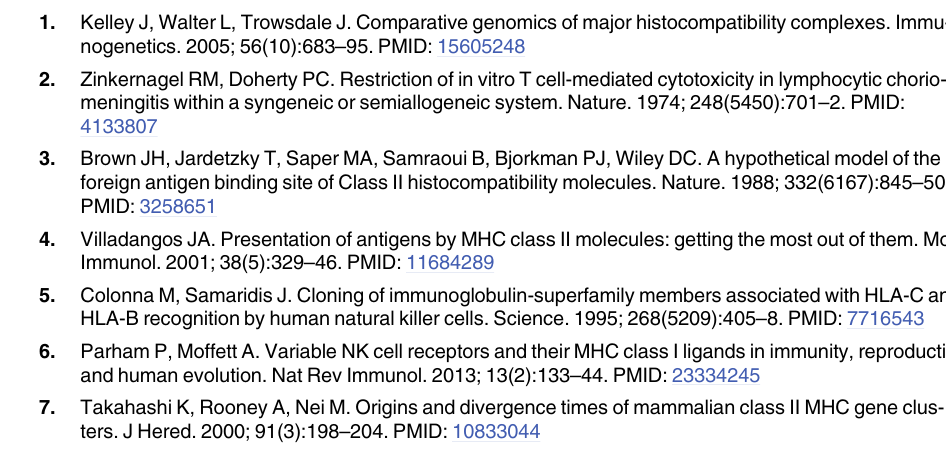
S2 Table. Characteristics of the chimpanzee fecal samples used for the detection SIVcpz vRNA. Listed are samples of chimpanzee feces that were all shown to contain SIVcpz-specific antibodies by western blotting. These samples are grouped according to the 30 chimpanzees from which they were collected. For each chimpanzee, the identity numbers and the Patr-B types are given. For each fecal sample, the identity number, the date of collection, and the com- munity territory (northern [N], central [C], or southern [S]) in which the collection was made, are given. These data are followed by the results of testing for the presence (+) or absence (-) of vRNA detected by PCR amplification. For each individual, the total number of fecal samples tested is given, as well as the number shown to contain vRNA. For chimpanzees from which vRNA was detected, the infecting strain of SIVcpz is identified by TAN followed by a number from 1 to